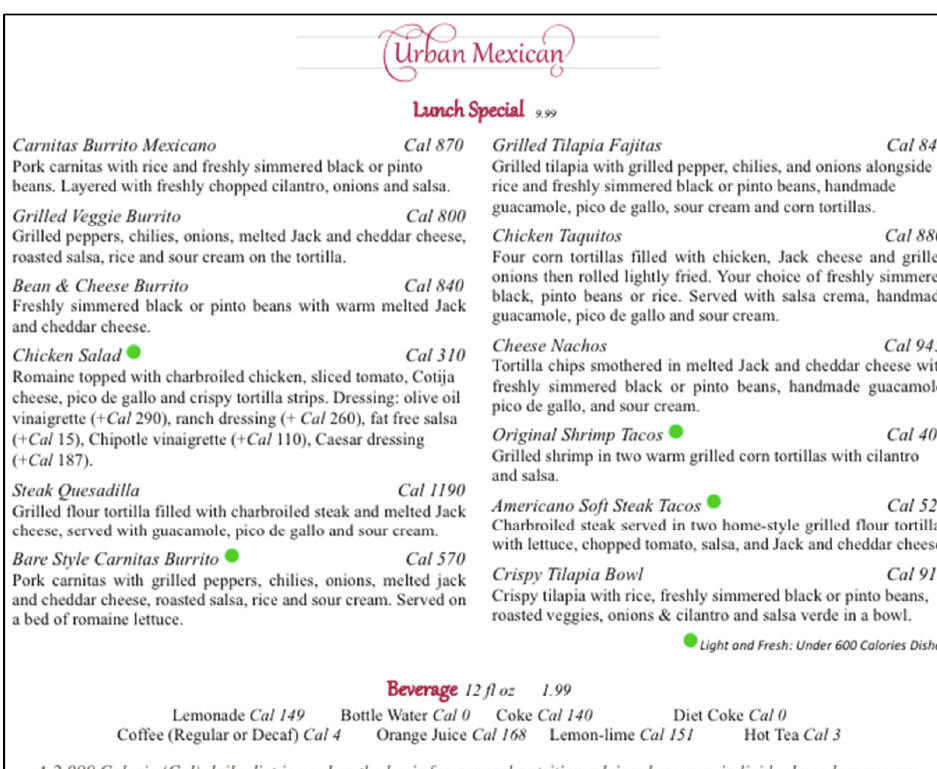
Figure A12. Urban Mexican Light and Fresh Menu.